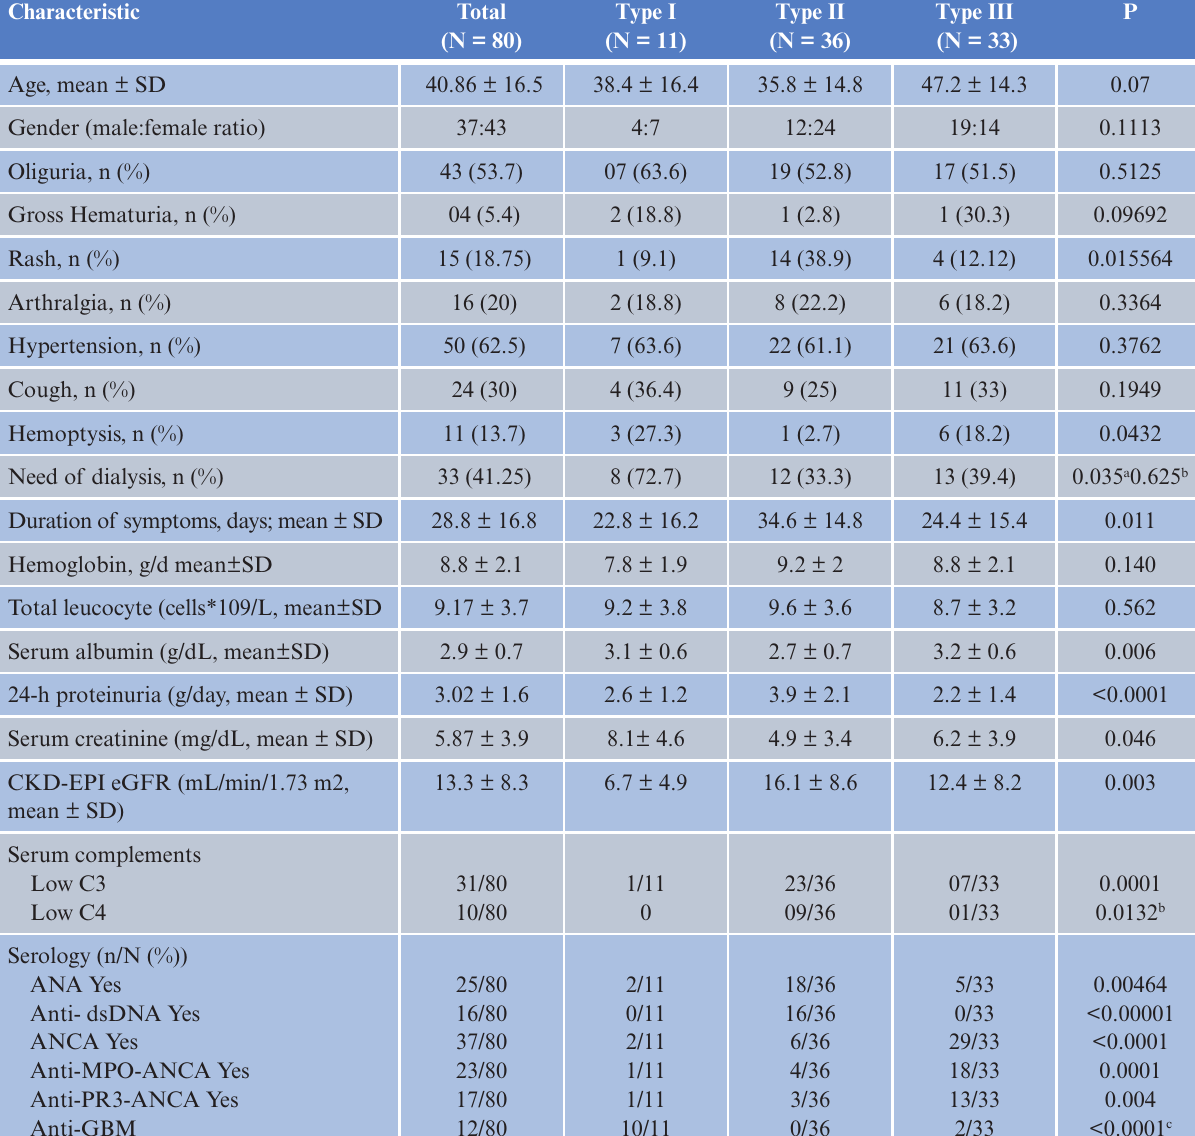
Table 2: Baseline demographic and clinical manifestations of patients with crescentic glomerulonephritis.